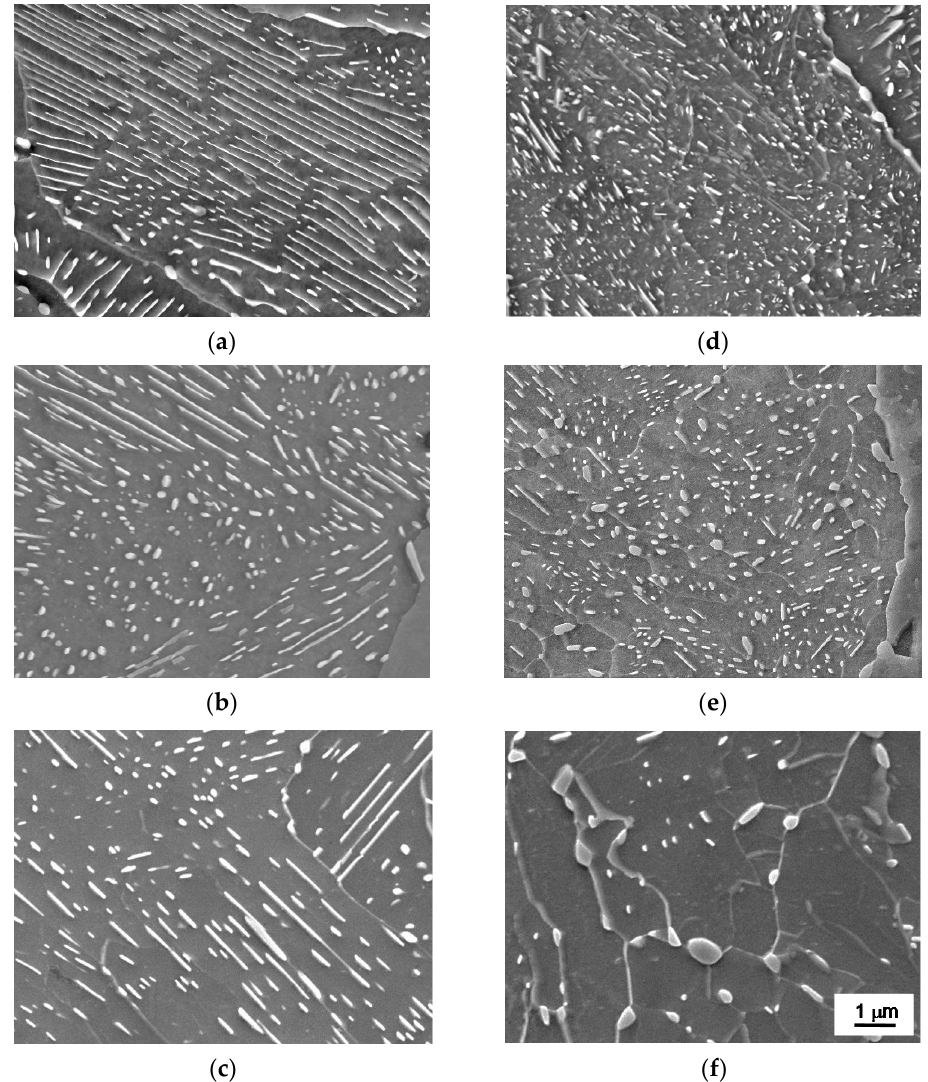
Figure 3. Coarse pearlite microstructure after short ( a ), long ( b ), and very long ( c ) spheroidization cycle. Idem for fine pearlite in ( d – f ).